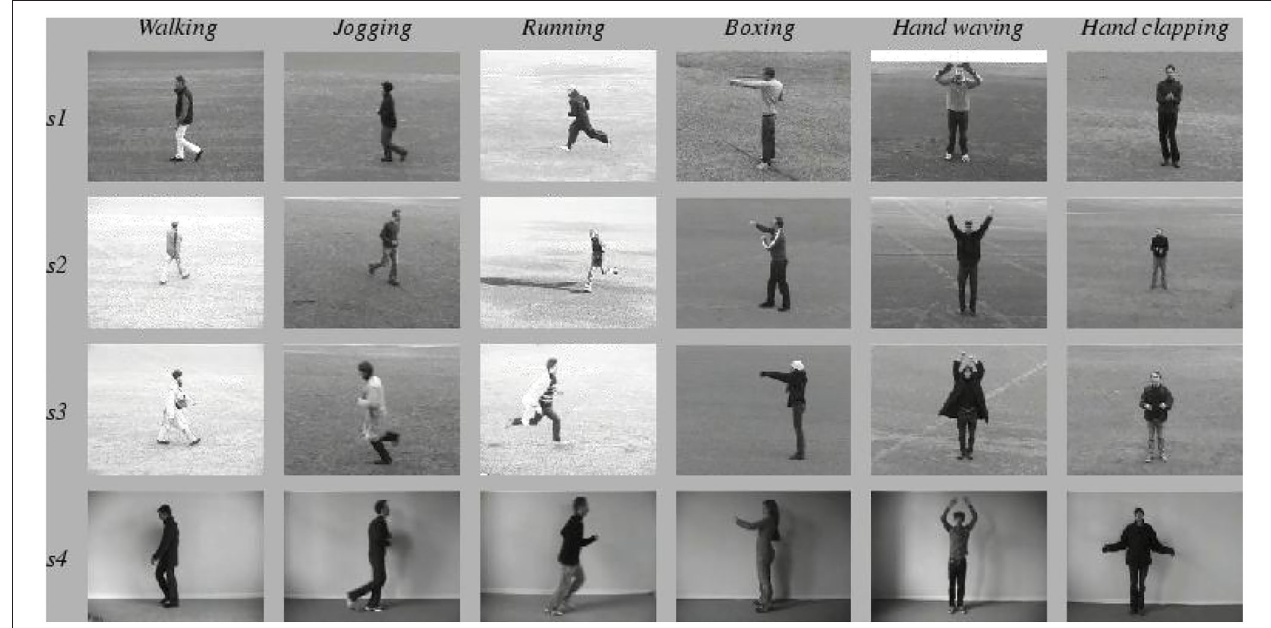
FIGURE 3 | Six types of behavior examples in KTH data